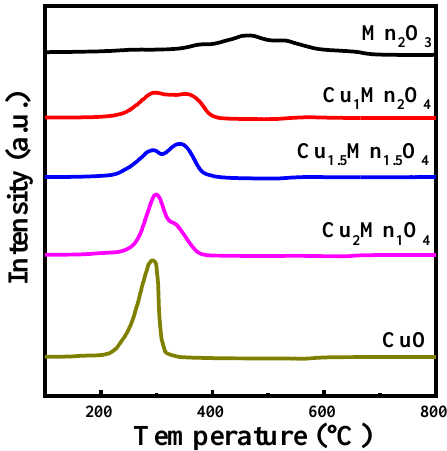
Figure 5. H 2 −TPR curves of the as -synthesized Cu x Mn 3-x O 4 samples. Figure 5. H 2 − TPR curves of the as-synthesized Cu x Mn 3 − x O 4